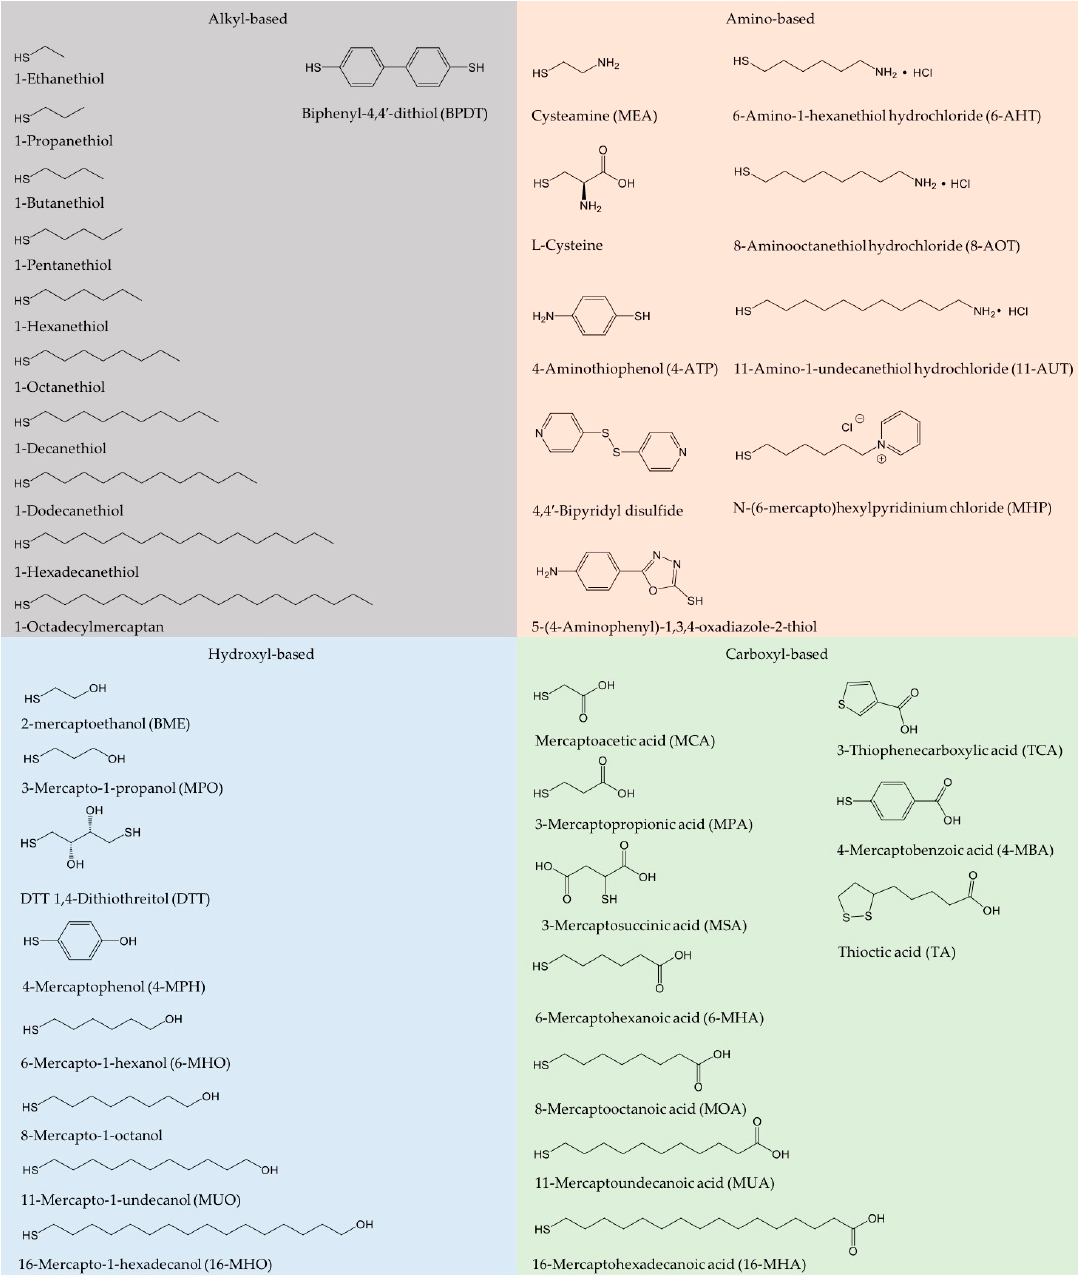
Figure 1. Frequently used alkanethiols and thiophenols in the formation of self-assembled molecular monolayers (SAMs) with alkyl, amino, hydroxyl, and carboxyl terminal groups.